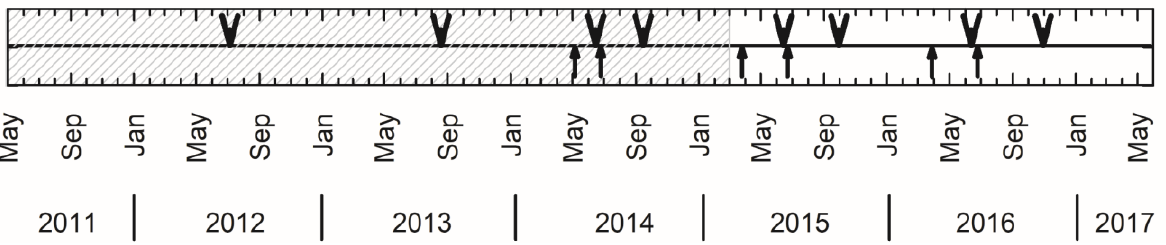
Figure 2. Timeline of harvest (arrowheads) and fertilisation (upward arrows) before (May 2011 – February 2015; hatched area) and during the study period (March 2015 – March 2017). The study site was ploughed and sown with reed canary grass in May 2011. The experimental rewetting of the flooded plots started on 28 March 2015. Plots were fertilised with standard mineral fertilisers (80-13-62 kg N-P-K ha –1